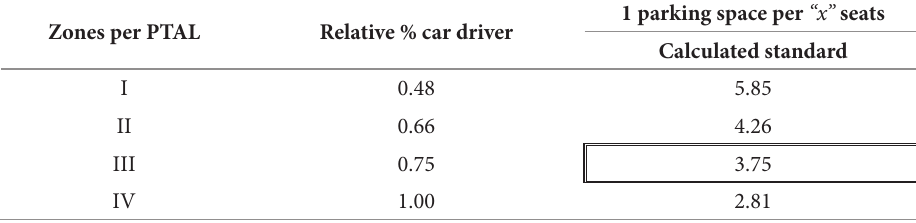
Table 8. Standard for cinemas and theatres